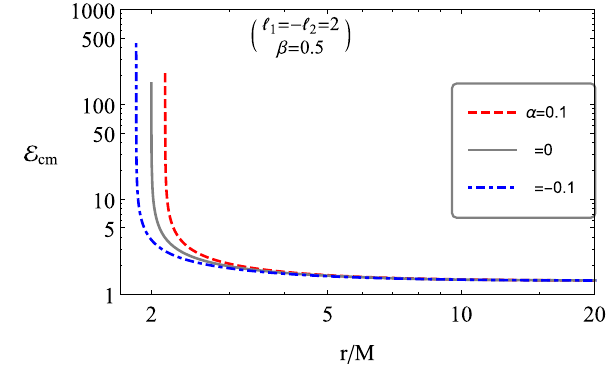
Fig. 8 Theradialdependenceofthecenter-of-massenergyofcollision of magnetized and neutral particles with the same initial energy E 1 = = 1, around Schwarzschild-MOG black hole for the different values E 2 of α